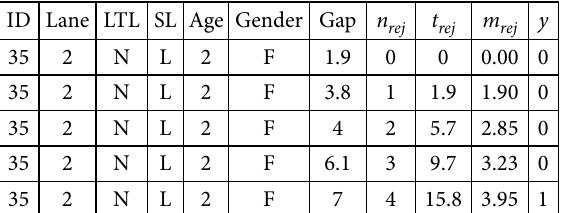
Table 4. Sample data records for one